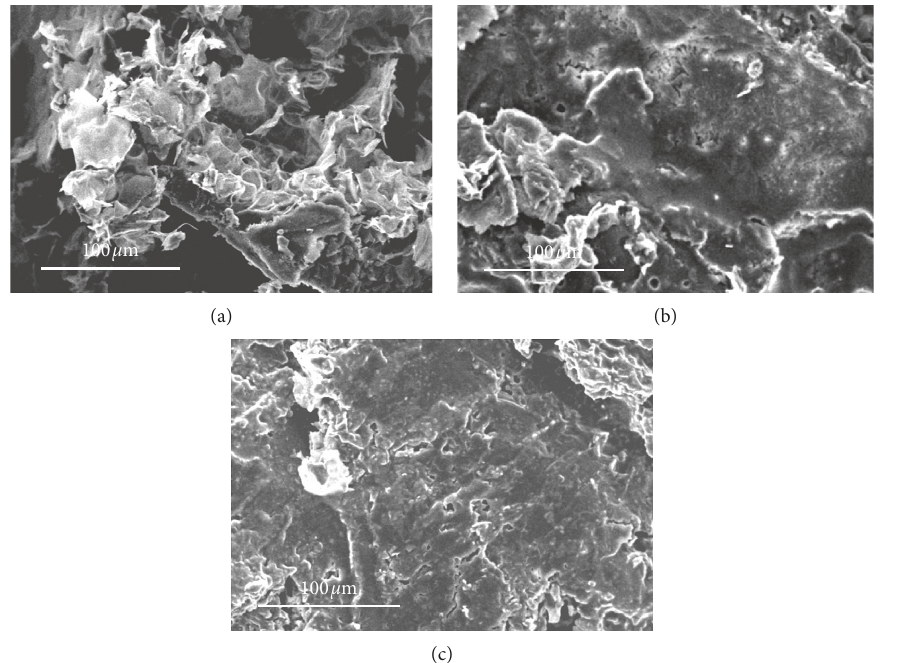
Figure 11: SEM of the char layer ( × 250): (a) IFR-PP (PER); (b) IFR-PP (PEPA); and (c) IFR-PP